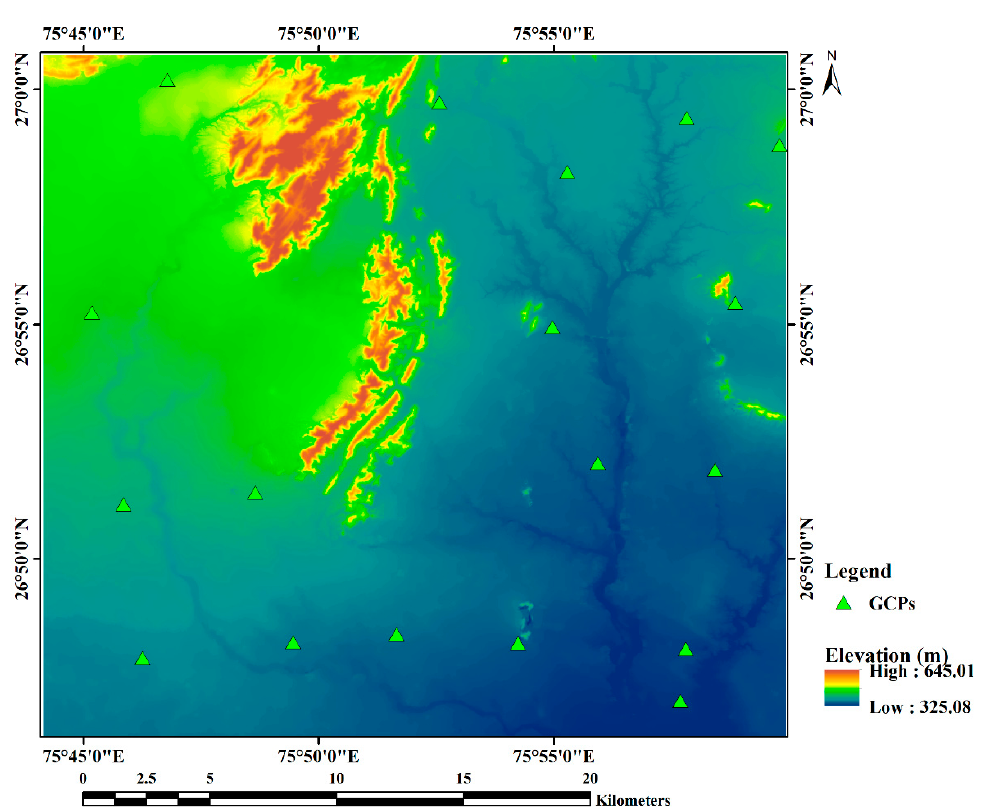
Figure 3. FABDEM for Jaipur site.